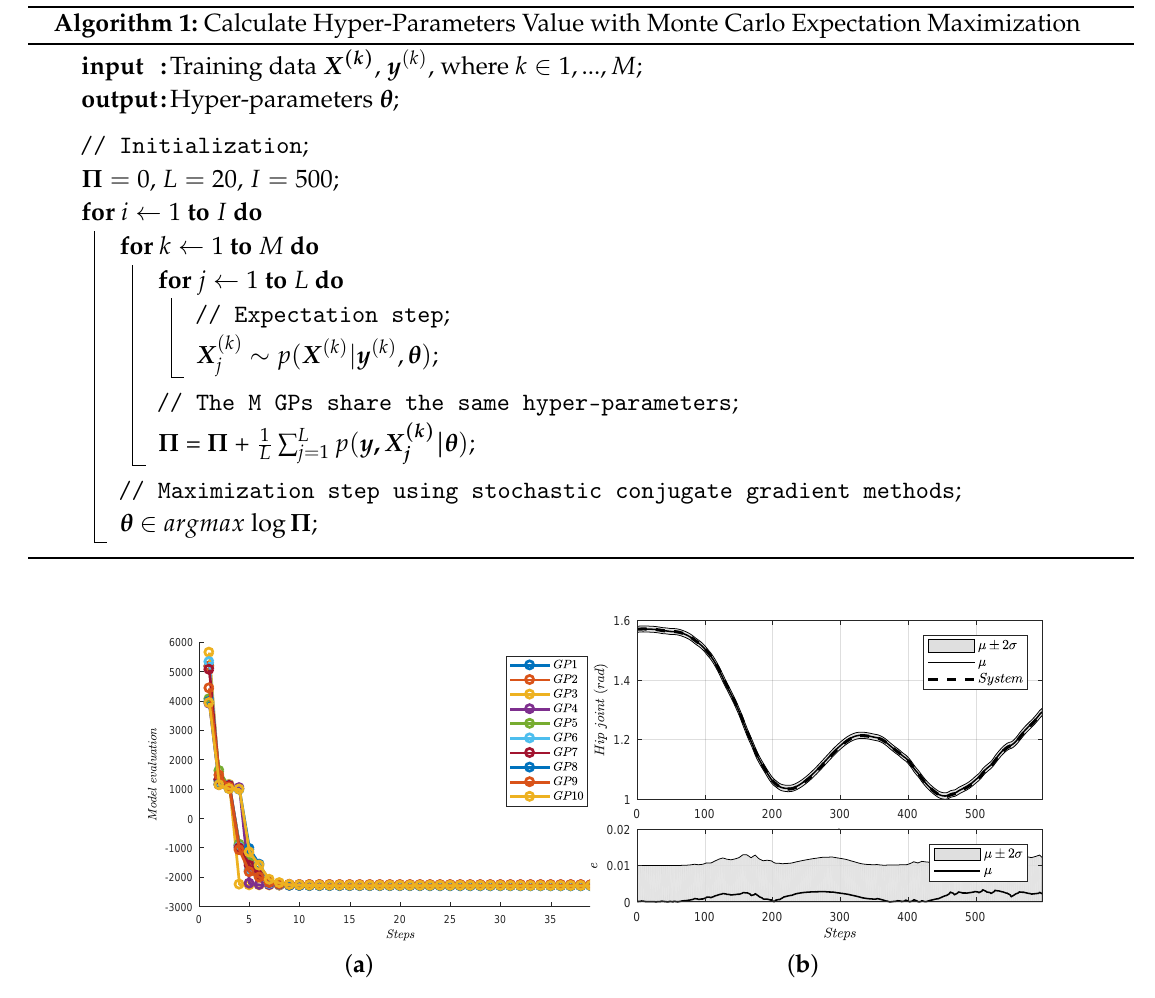
Figure 6. Learning procedure and cross-validation of the distributed forward model. ( a ) Learning procedure hyper-parameters of 10 GPs; ( b ) cross-validation of learned forward model. The efficient training process has been explained in the above figure. In addition, since the trust region of the trained model is about 0.57 deg, the precision for the practical experiment can be accepted.